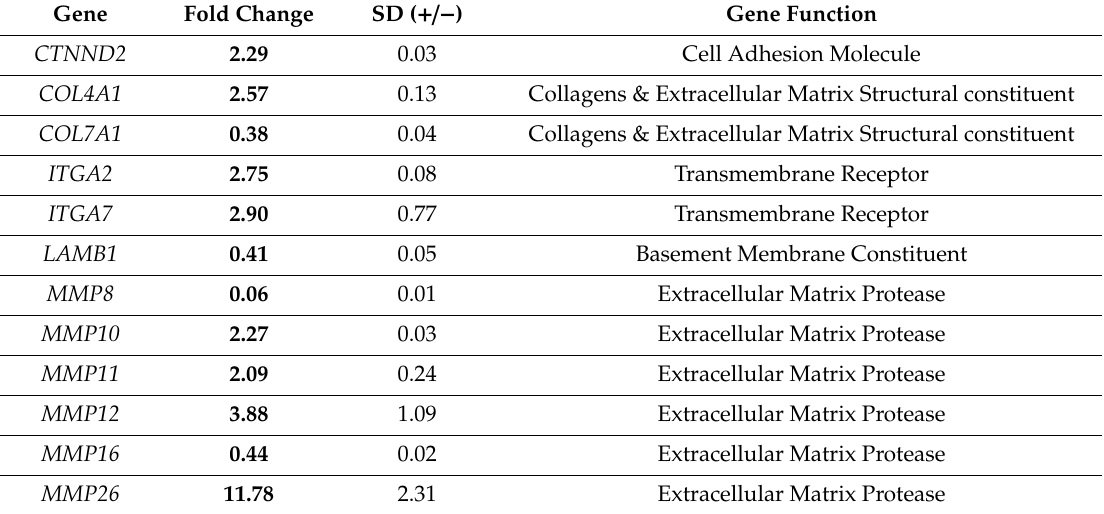
Figure 1. Gene expression profile of fibroblast treated with Amlodipine 1000 ng/mL. Table 1. Significant gene expression levels after 24 h treatment with Amlodipine, as compared with untreated